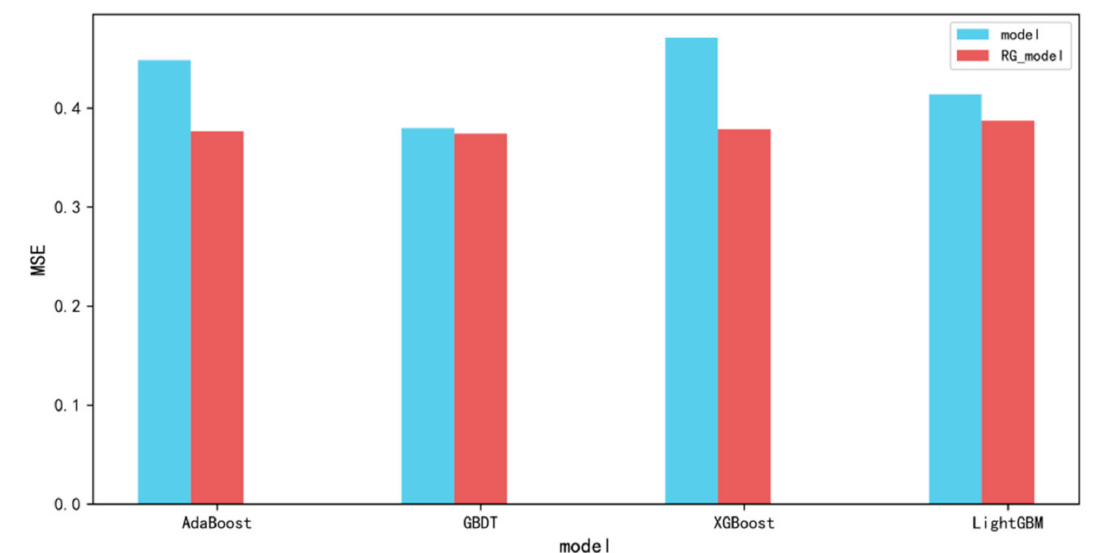
Figure 6. The prediction performance improvement, in terms of MSE, of boosting ensemble learning models after enriching them by the proposed RG hyperparameter optimization.